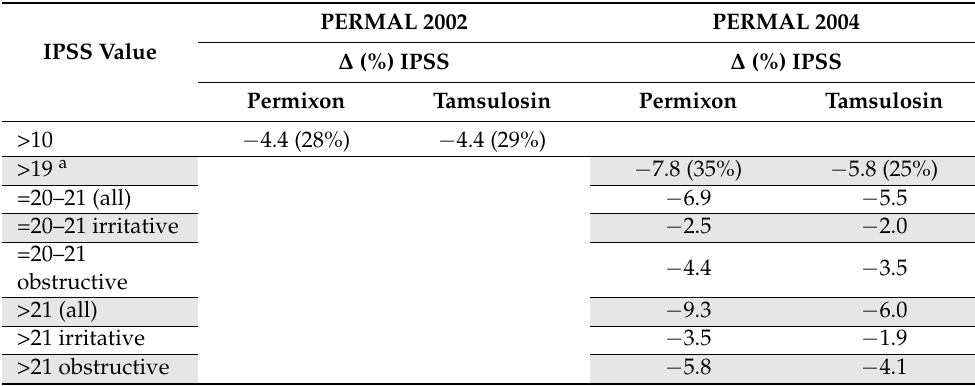
Table 4. Comparative changes in IPSS with Permixon vs. tamsulosin from PERMAL (adapted after Debruyne 2002 [10] and Debruyne 2004